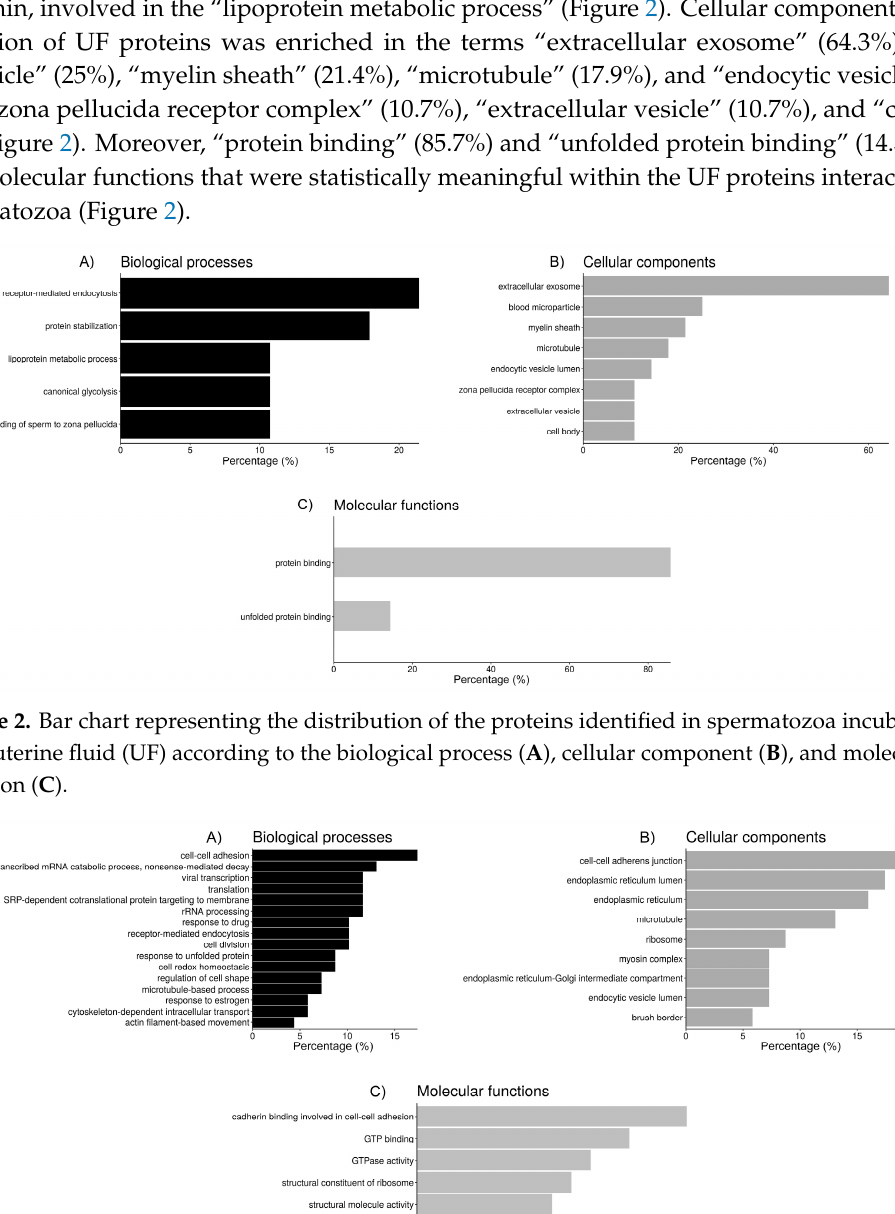
Figure 4. Bar chart representing the distribution of the proteins identified in spermatozoa incubated with seminal plasma (SP) according to the biological process, cellular component, and molecular function. Clustering of the biological annotations for UF proteins showed limited results. The first cluster (Table 3), with an enrichment score (ES) of 3.4, shows proteins present in blood microparticles, some involved in receptor-mediated endocytosis, and the lipoprotein metabolic process. The second cluster (ES = 2.8) includes proteins involved in protein stabilization, which can bind unfolded proteins. Some of these proteins are allocated in the zona pellucida receptor complex.